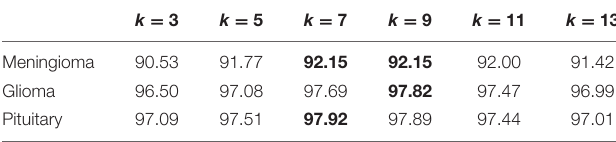
The bold values represent the best results in comparison experiments.